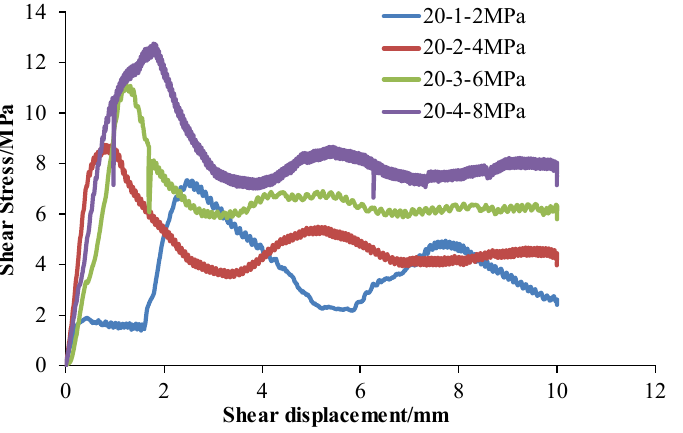
Figure 6. Shear stress–displacement curves under different normal stresses at a 0.6 mm/min shear rate with a 20° undulating angle.